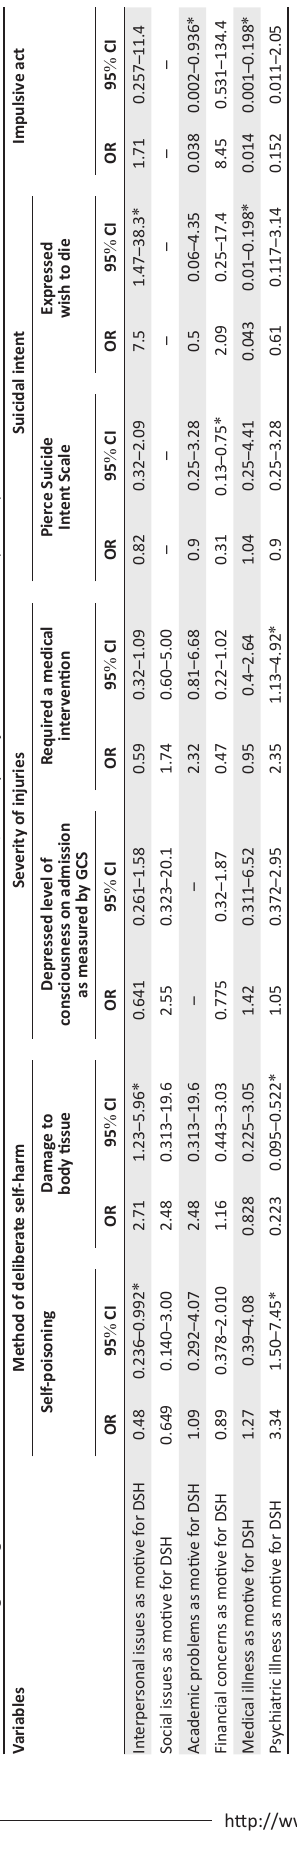
motive, 8 reported self-poisoning as their method of DSH.